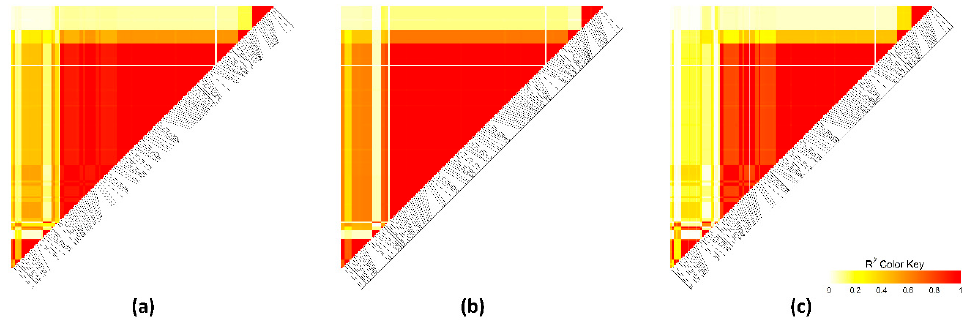
Figure 6. Linkage disequilibrium plot at 46.0–49.2 Mb on chromosome 18. Colors from white to red indicate r 2 value. ( a ) All lines. ( b ) High-IMF line. ( c ) Low-IMF line